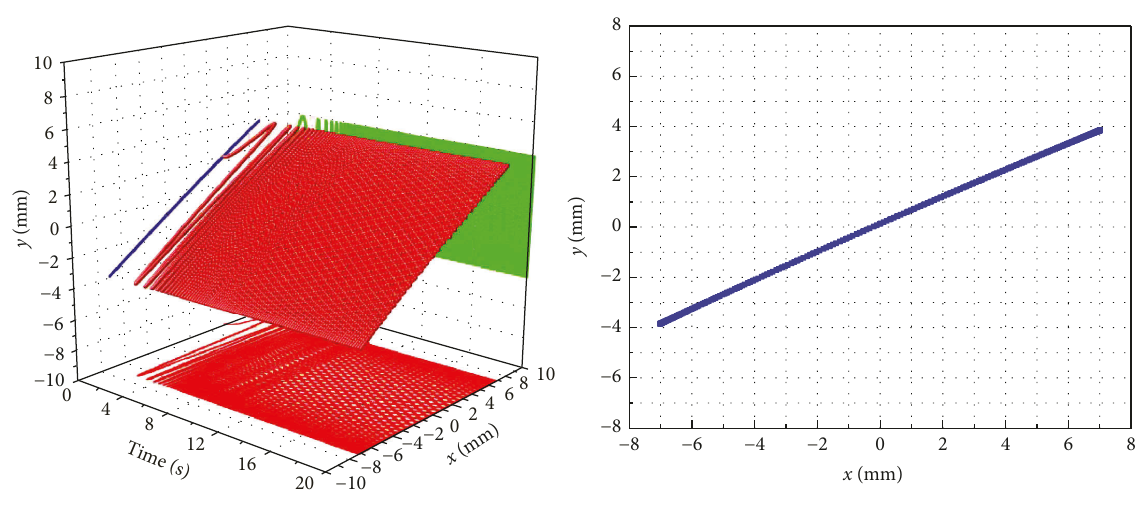
Figure 5: Space-time curve and Lissajous figure of displacement about the